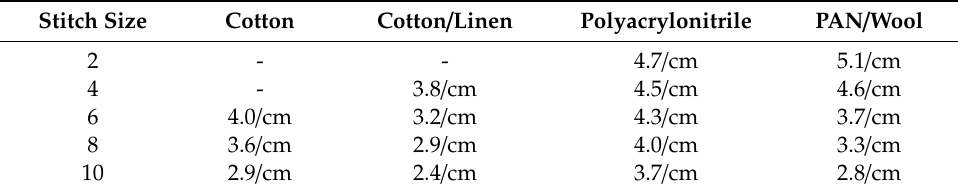
Table 6. Wale density of knitted fabrics under examination in this study.